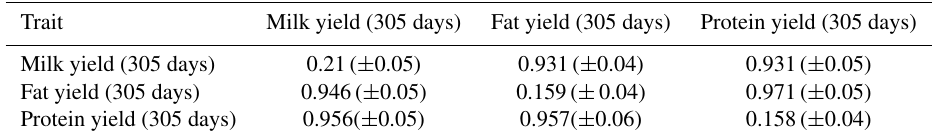
Table 5. Genetic (above diagonal) and permanent environmental (below diagonal) correlations (SD in brackets) and heritabilities (diagonal) for 305 days of milk, fat, and protein yields by REML